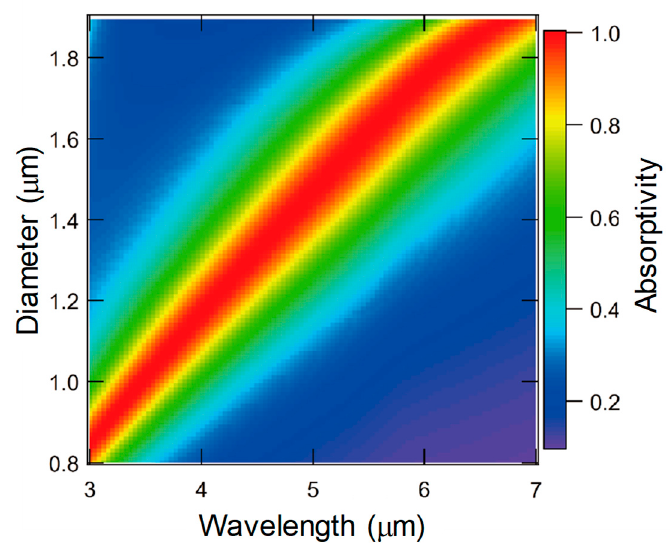
Figure A6. Simulated spectral absorptivity/emissivity map to the diameter of an MDM metasurface composed of HfN and SiO 2 with P = 2.0 µm, T g = 130 nm, and T d = 200 nm.